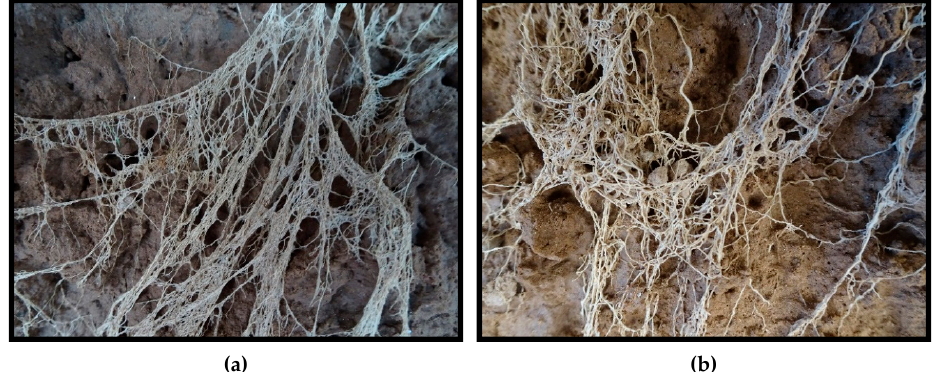
Figure 6. Di ff erent root phenotypes exhibited under high and low irrigation: ( a ) “Cochise” roots at 30–40 cm under high irrigation; ( b ) “Solum” roots at 30–40 cm under low irrigation.